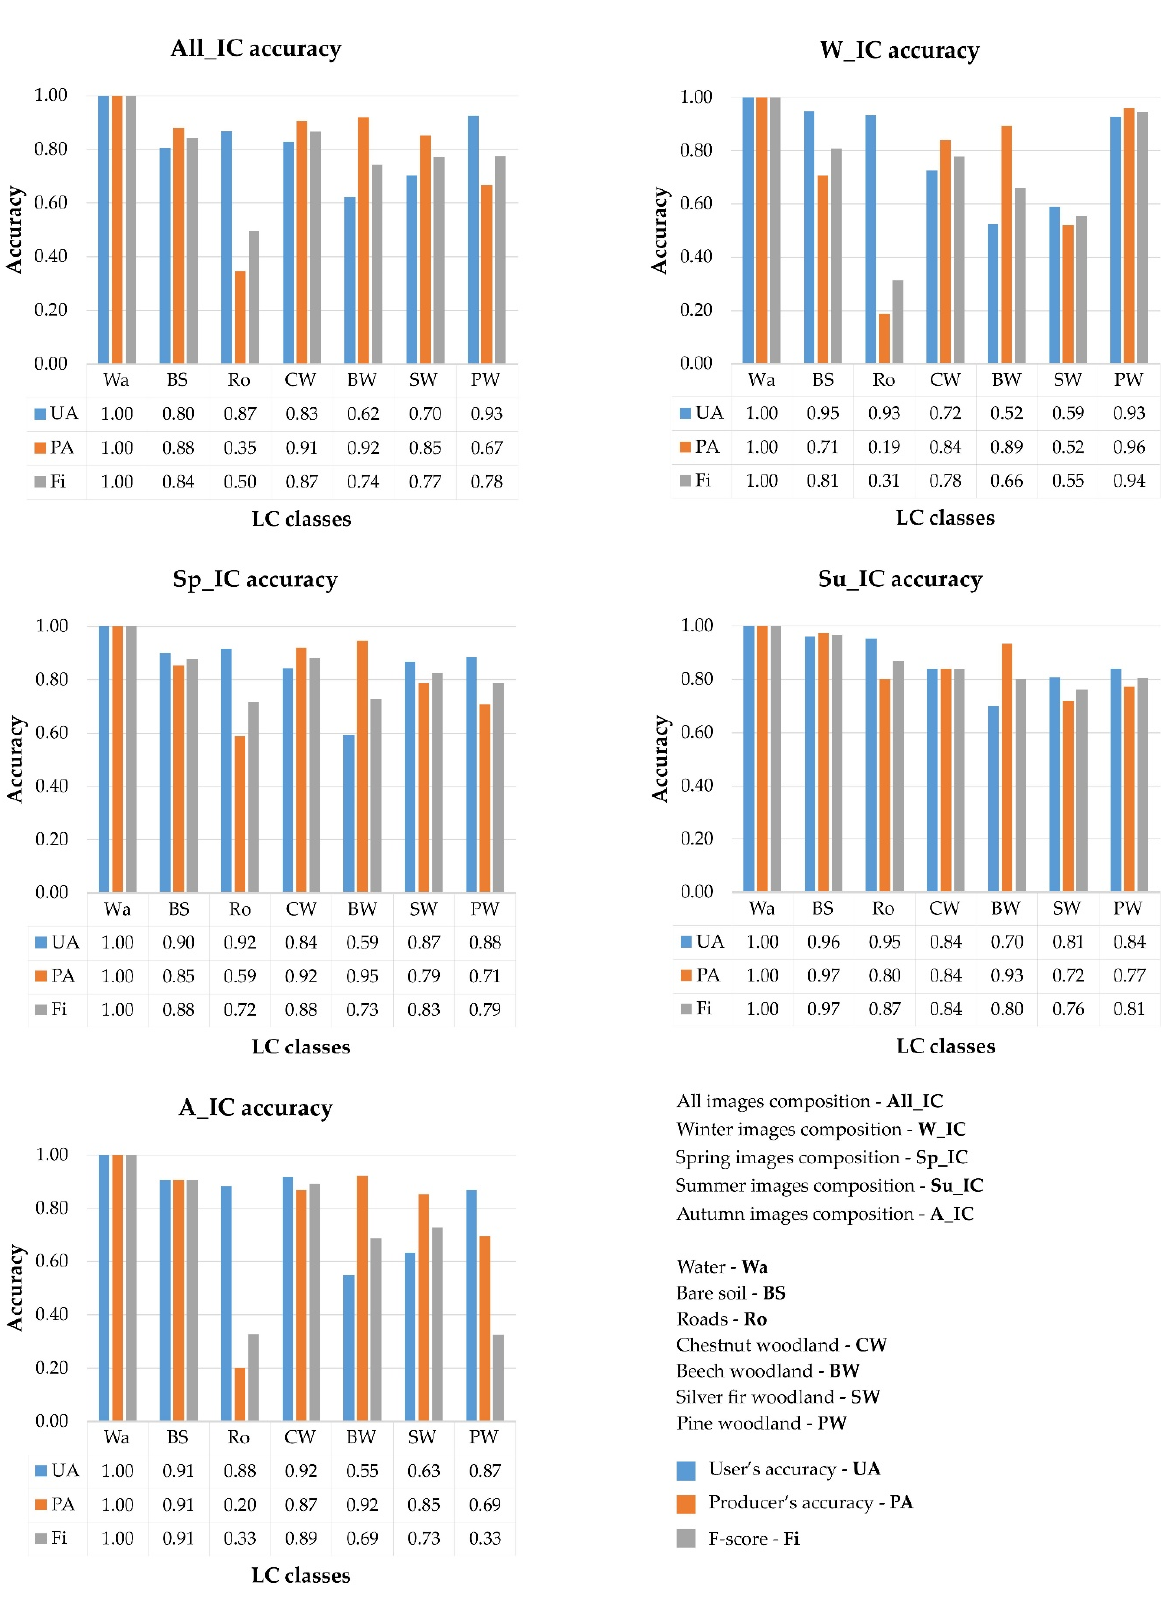
Figure A1. Seasonal image composition accuracy values.